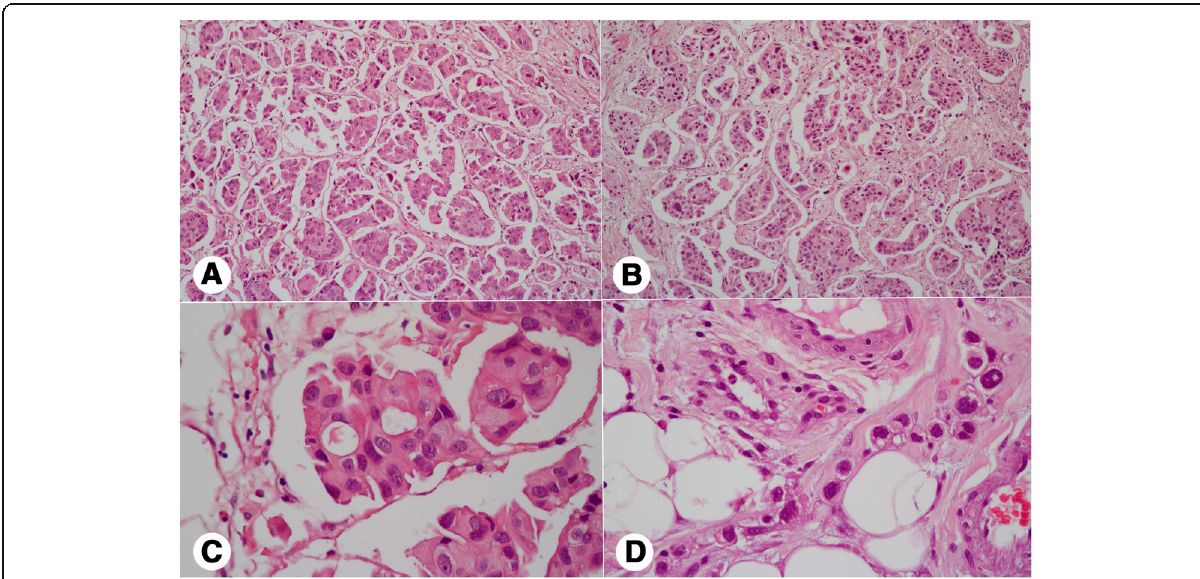
Fig. 3 Micropapillary variant of urothelial cancer ( a 40×) showing multiple epithelial nests within a single lacuna ( b 100×) and epithelial ring formation ( c 400×). Plasmacytoid variant of urothelial cancer ( d